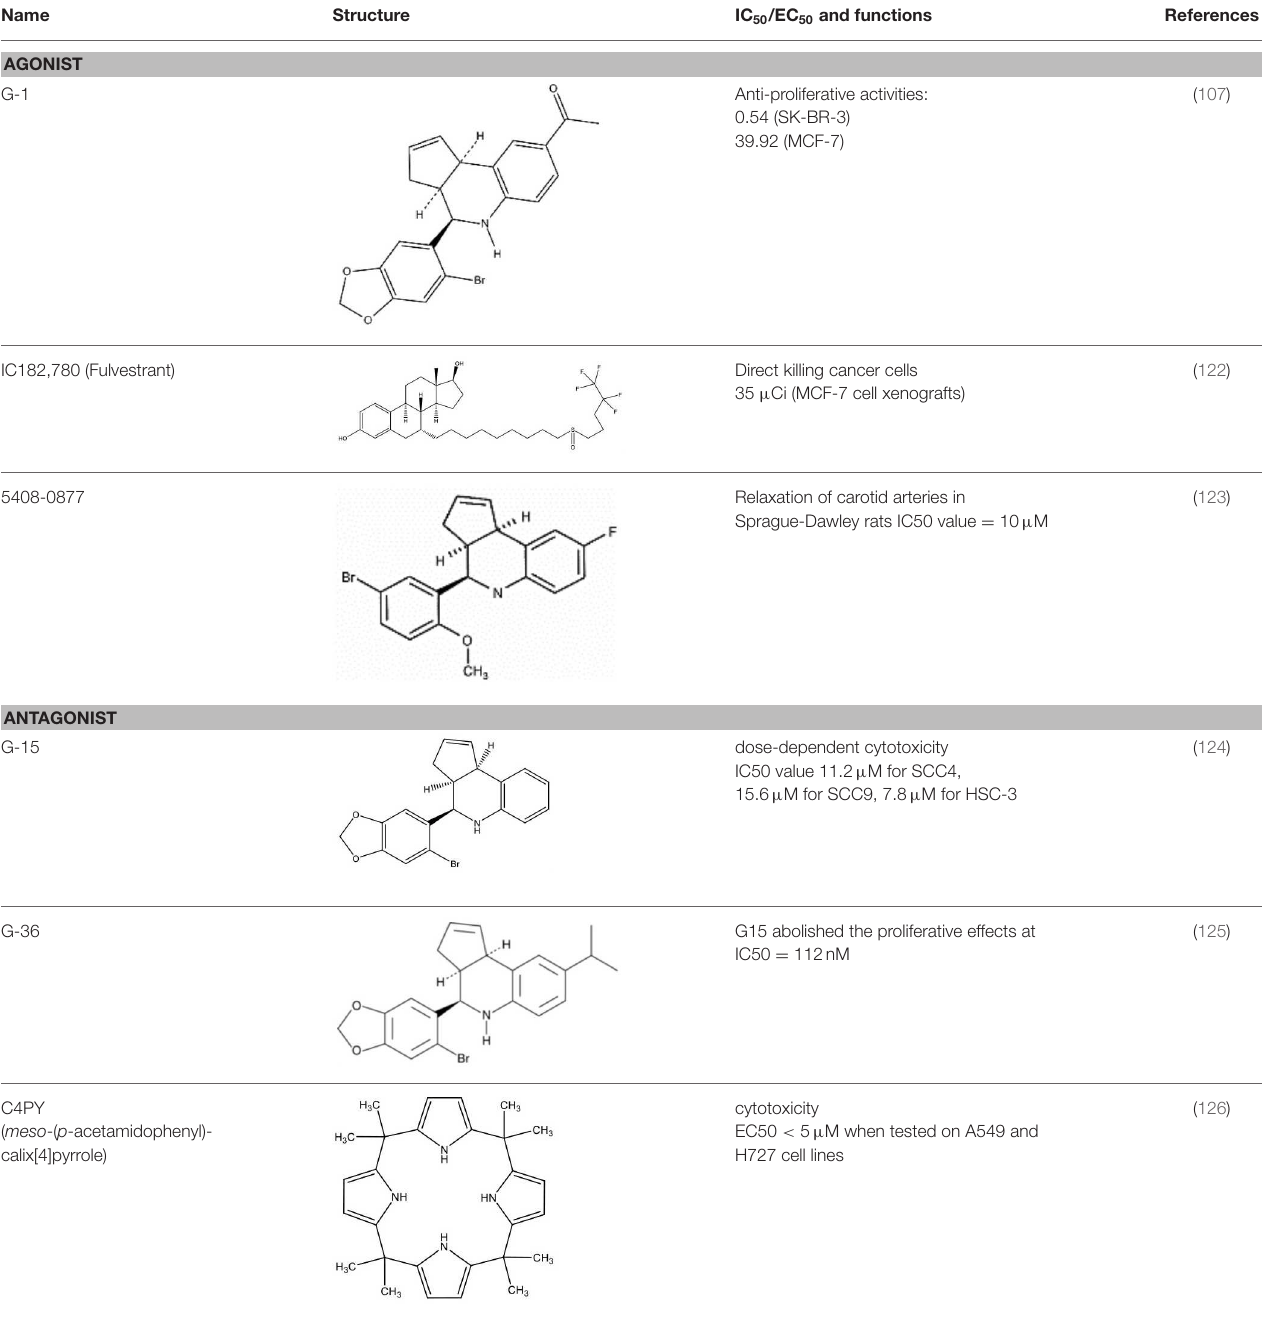
TABLE 1 | Structure and functions of GPER agonists and antagonists.